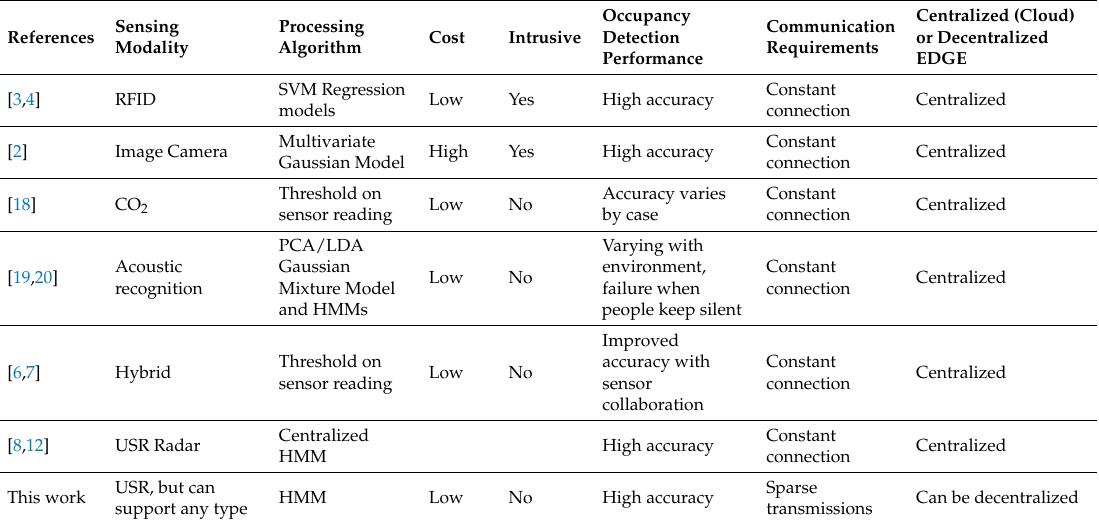
Table 1. Occupancy detection mechanisms comparison